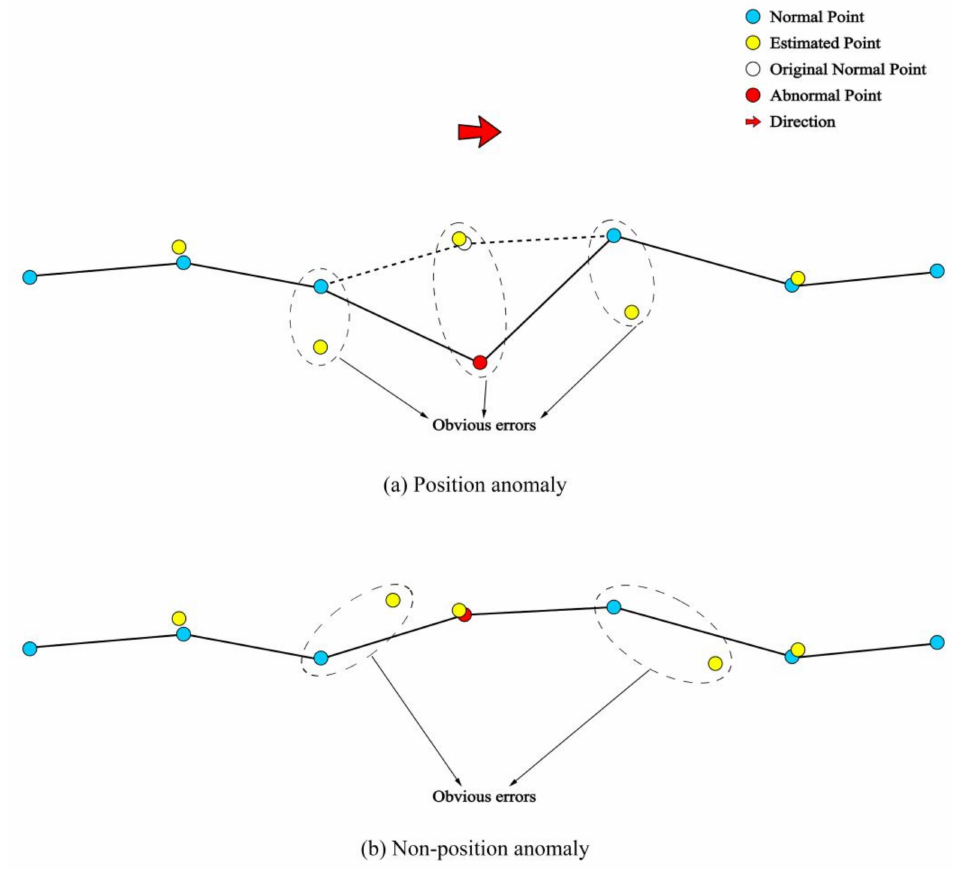
Figure 4. Continuous error estimation and determination for a ship